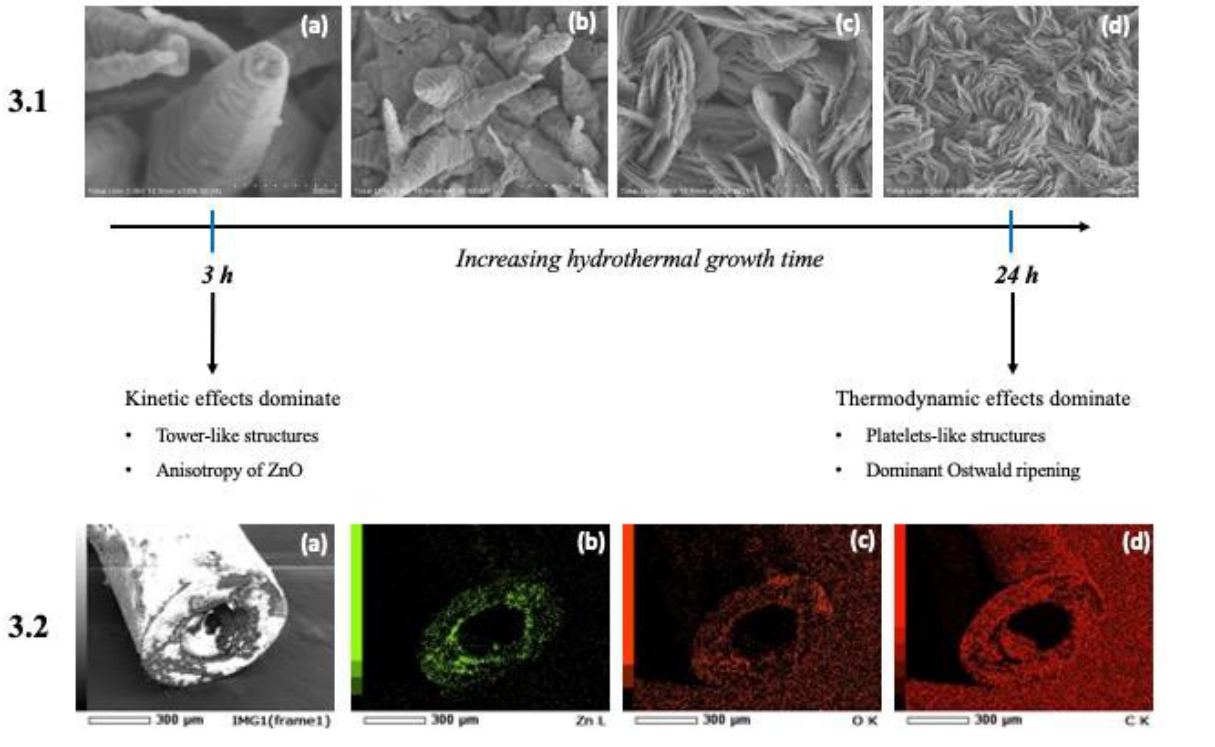
Figure 3. ( 3.1 a – d ) SEM images showing the reaction-time-dependent hydrothermal growth of ZnO nanostructures. ( 3.2 ) Elemental analysis maps representing the distribution of ( b ) Zn, ( c ) O, and (d) C elements near the tip end of the micropipette tip (a – represents the region studied for elemental distribution).